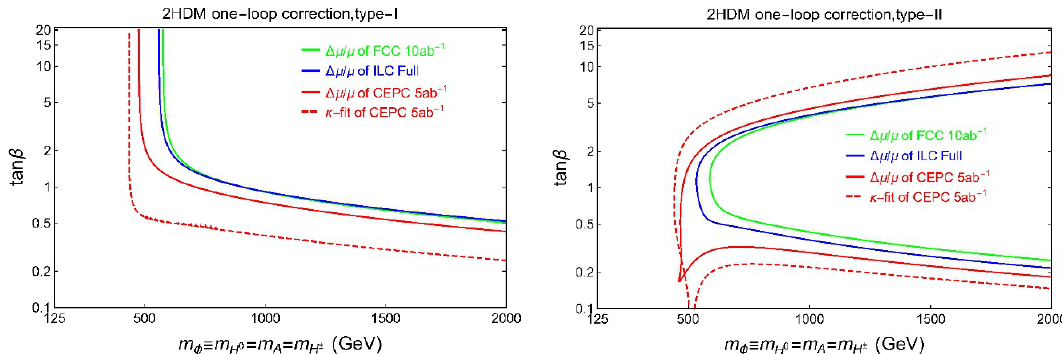
Figure 8 . 95% C.L. Higgs precision constrained regions in m (cid:30) vs. tan (cid:12) for CEPC (red lines), ILC (blue lines), and FCC-ee (green lines). Left panel is for Type-I and right panel is for Type-II with p (cid:21)v 2 = 300 GeV. The CEPC results using (cid:20) -(cid:12)t are shown in red dashed lines.